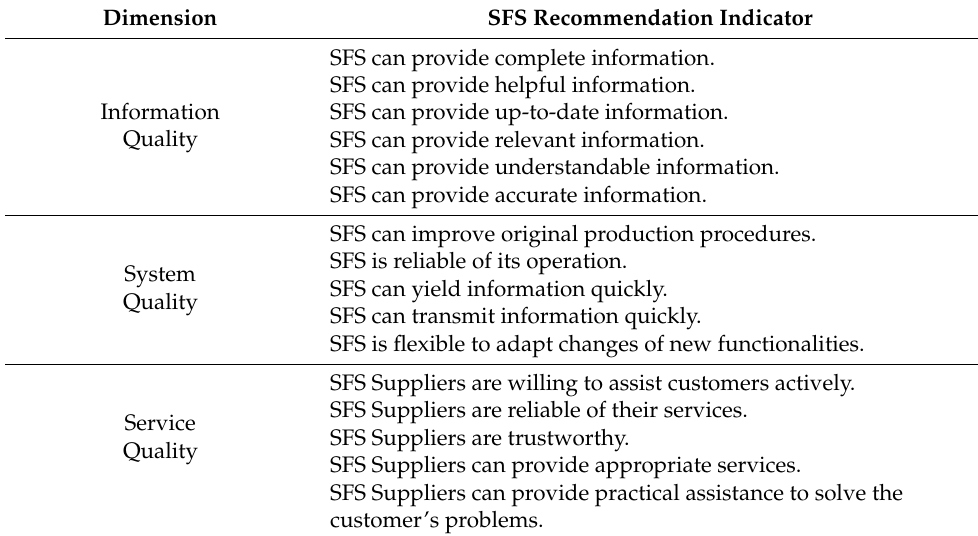
Table 3. SFS Recommendation indicator of three types of